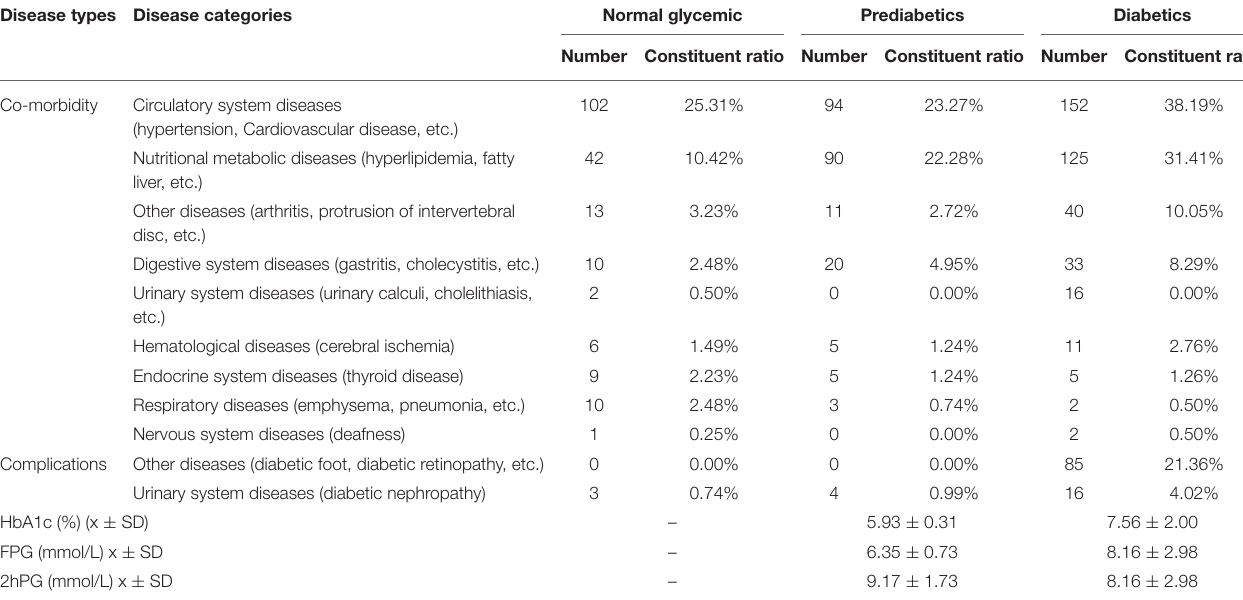
TABLE 2 | Composition and blood glucose status of the three groups. Disease types Disease categories Normal